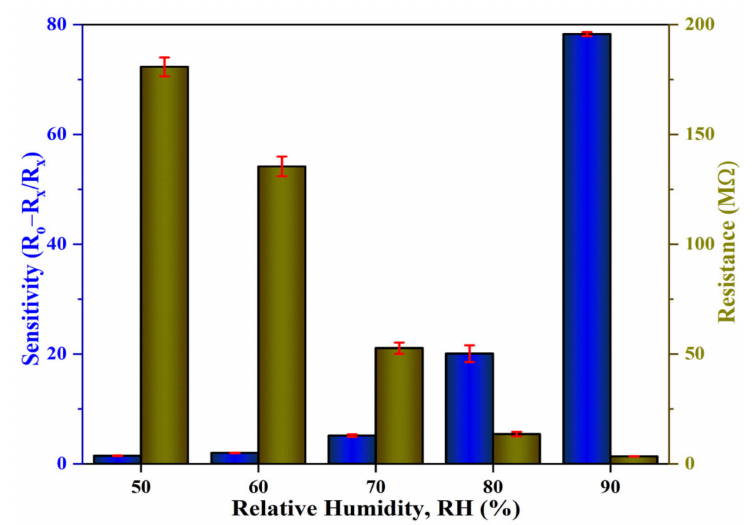
Figure 15. Correlation of the resistance and sensitivity of the Al:ZnO-4 h nanostructured-based flexible humidity